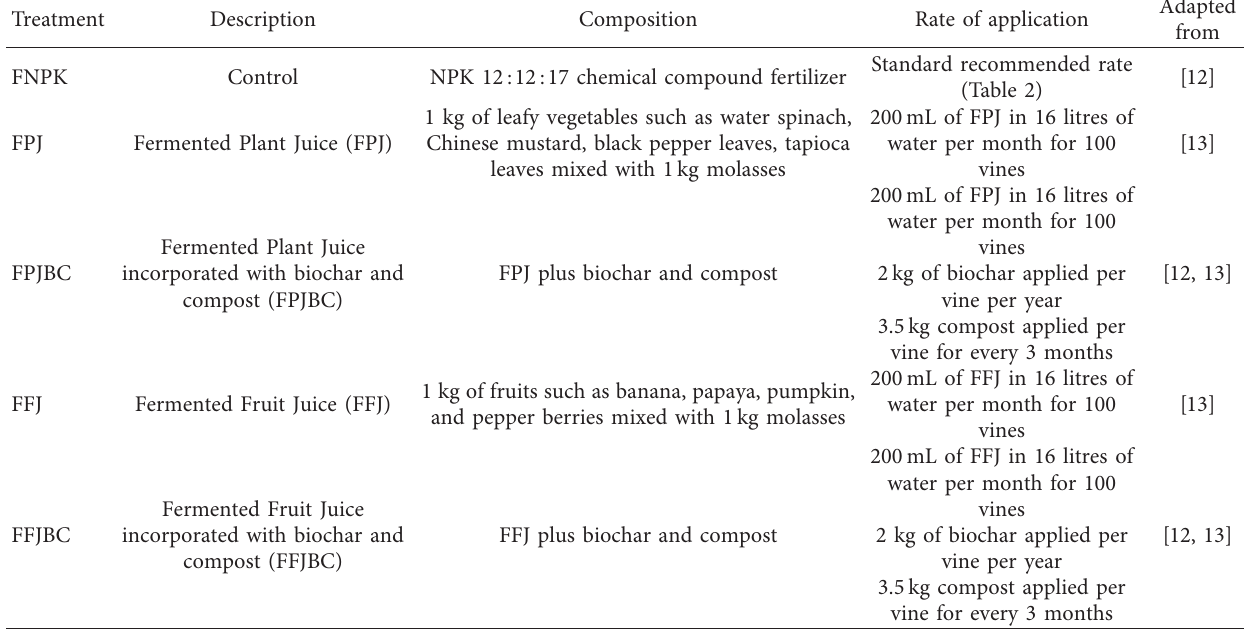
Table 1: Soil amendments description, composition, and rate of application for mature pepper vines. Treatment